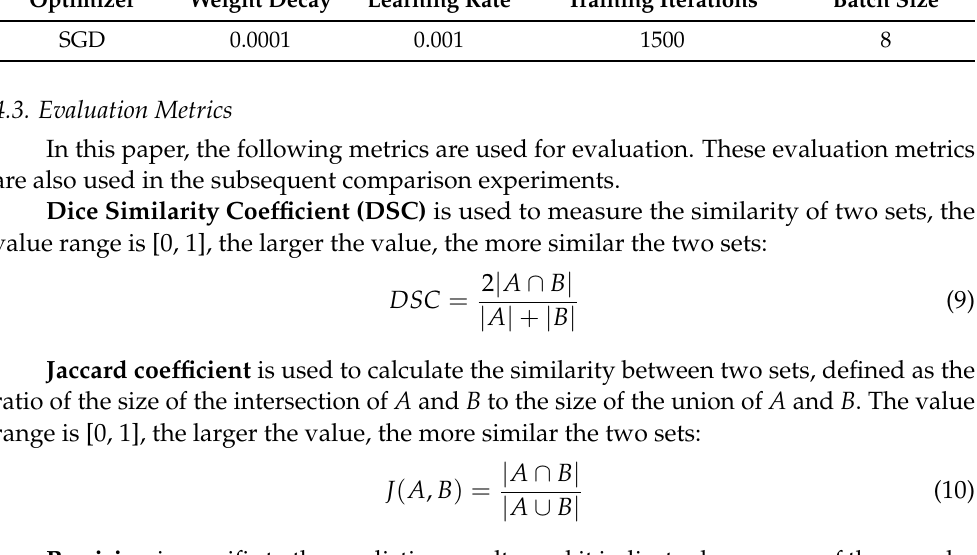
Table 1. The main setting of hyperparameters for CAFS. Optimizer Weight